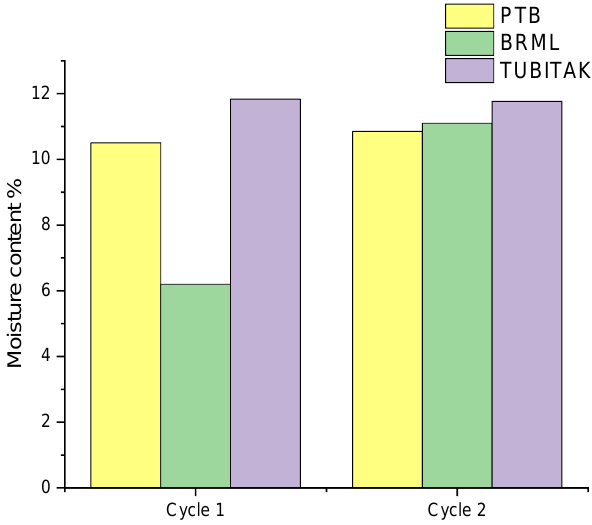
Figure 5. Moisture content of the WC-HQ in the institutes for cycle 1 and cycle